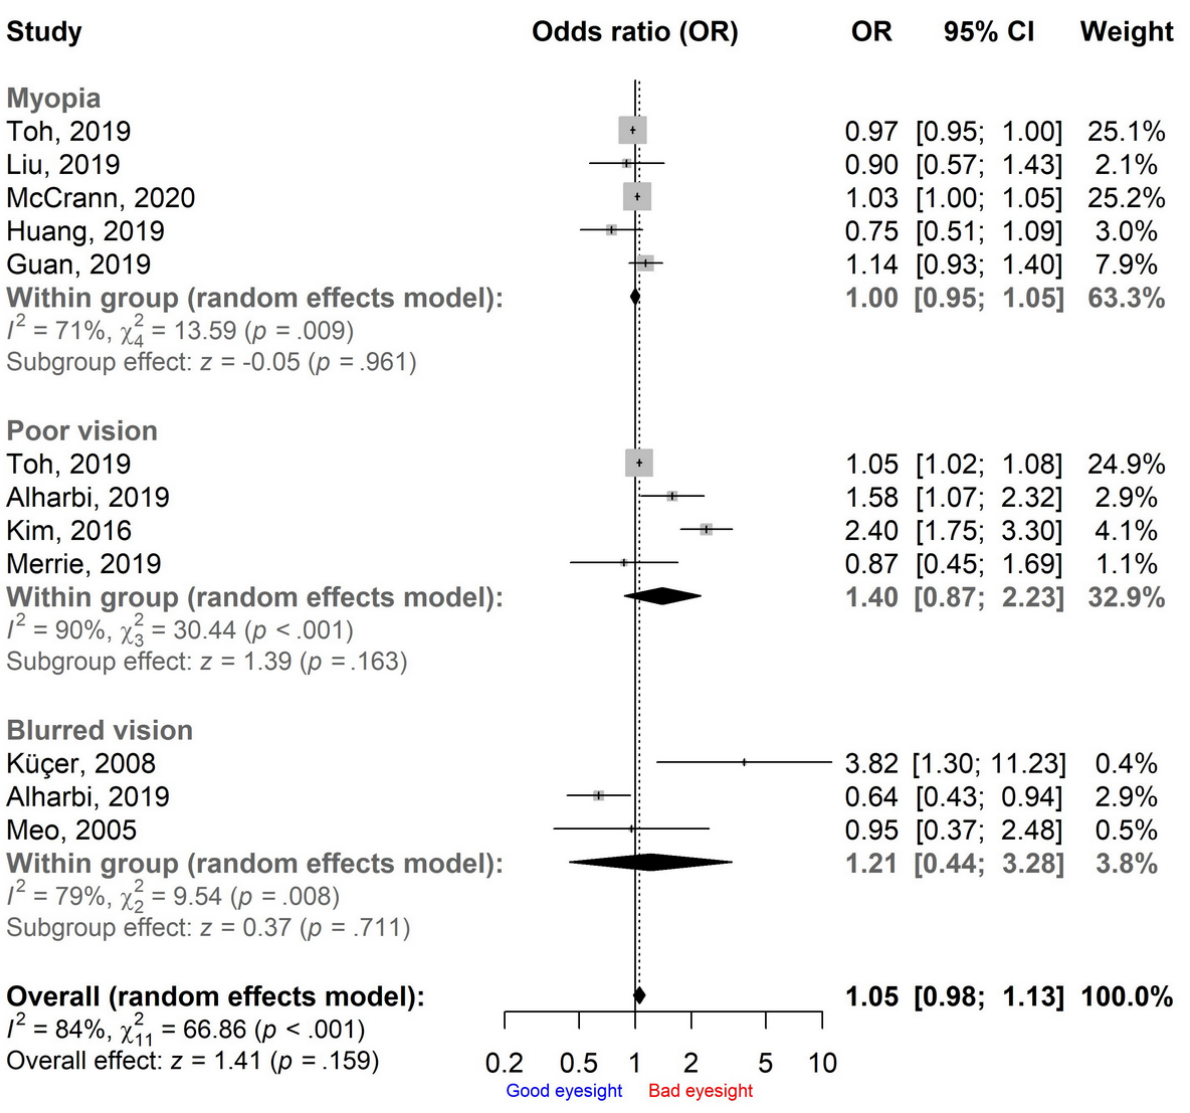
Figure 3. Pooled odds ratios (ORs) of visual impairment in the smartphone overuse group compared to the reduced-use